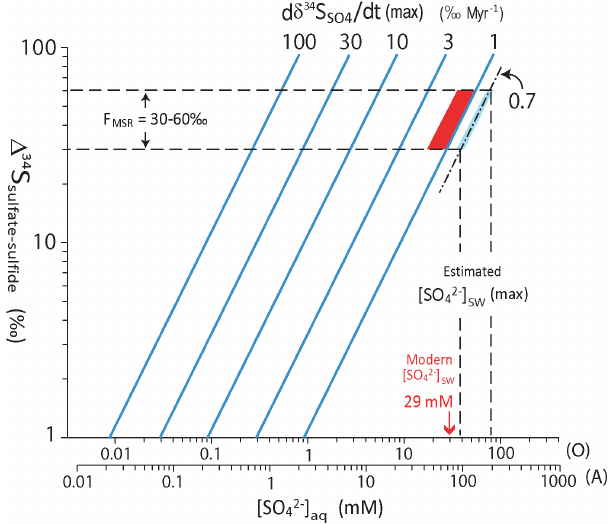
Figure 1. The rate method. On a crossplot of aqueous sulfate con- centration ([SO 2 − ] aq ) versus S-isotopic fractionation between co- 4 genetic sulfate and sulfide ( (cid:49) 34 S sulfate-sulfide ), the diagonal blue lines represent maximum rates of change in sulfate δ 34 S (i.e., ∂δ 34 S SO4 /∂t (max)). For paleomarine systems, maximum sea- water sulfate concentrations ([SO 2 − ] SW (max)) can be estimated 4 from the abscissa based on measured values of (cid:49) 34 S CAS-PY and ∂δ 34 S CAS /∂t (max). The two scales on the abscissa represent [SO 2 − ] SW in oxic (O) and anoxic (A) oceans, in which pyrite 4 burial fluxes are equal to 4 × 10 13 and 10 × 10 13 gyr − 1 (i.e., 40 and 100% of the modern total sulfur sink flux), respectively. The typi- cal range of (cid:49) 34 S sulfate-sulfide due to MSR fractionation in modern marine systems is 30–60‰ (Habicht and Canfield, 1997). The max- imum rate of seawater sulfate δ 34 S variation during the Cenozoic is ∼ 0.7‰Myr − 1 (Paytan et al., 1998), yielding estimates of ∼ 40– 80mM for [SO 2 − ] SW through projection to the abscissa (dashed 4 lines). These estimates exceed actual modern seawater [SO 2 − ], 4 which is ∼ 29mM (Millero, 2005), because the measured maxi- mum rate of ∂δ 34 S SO4 /∂t (light-blue parallelogram) is less than the theoretical possible maximum rate ( ∼ 1–2‰Myr − 1 ; red paral-